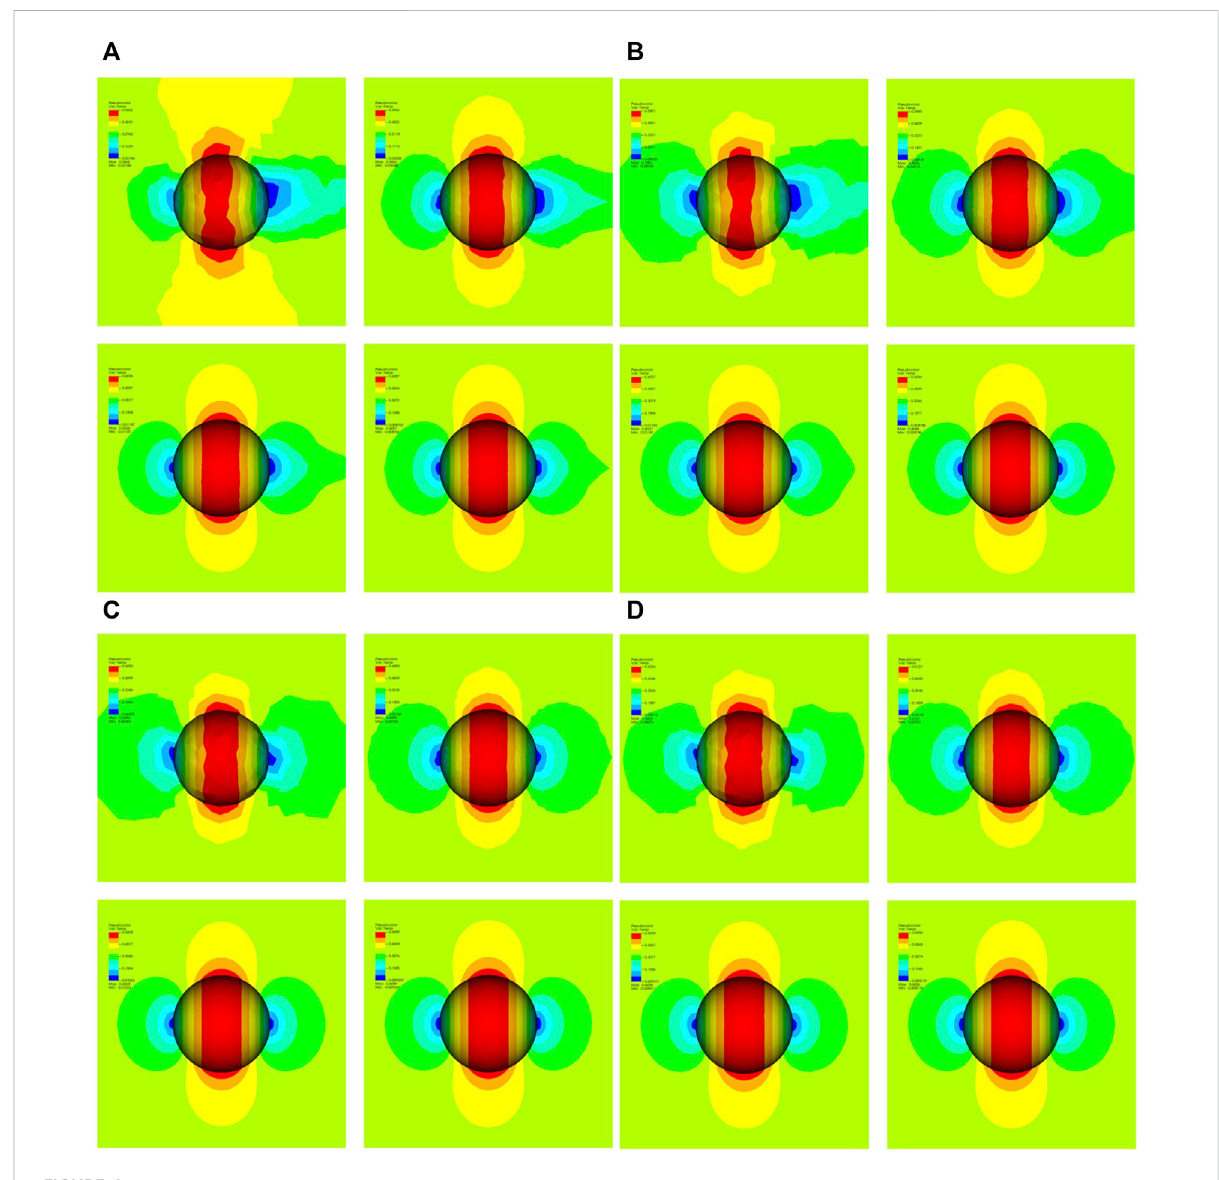
P Q 2 2 element on 0.4, 0.2,